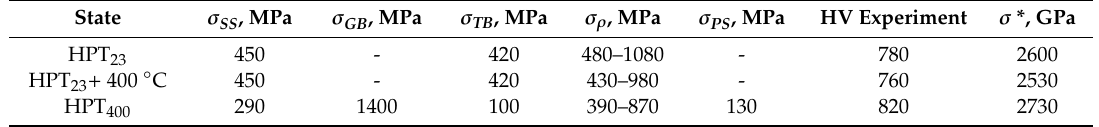
Table 3. Contributions of strengthening factors for Fe-13Mn-1.3C steel in cold and warm HPT: solid solution strengthening σ SS (Equation (2)), twin boundary factor σ TB (Equation (4)), grain boundary factor σ σ ρ (Equation (6)), precipitate strengthening σ TB (Equation (5)), dislocation density PS (Equation